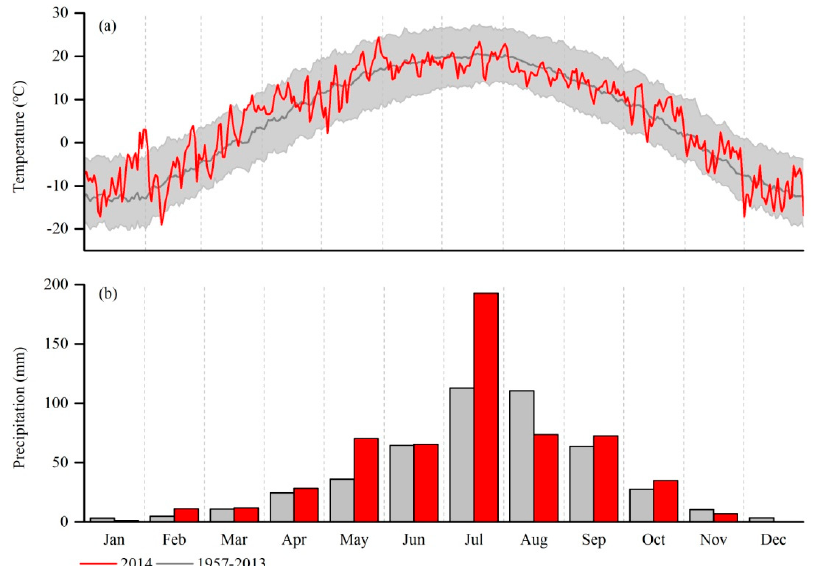
Figure 2. Comparison of ( a ) the mean daily air temperatures and ( b ) the monthly sums of precipitation for the monitoring year of 2014 (red) and the 1957–2013 average (light grey). The grey shading in ( a ) indicates the mean minimum and maximum temperatures averaged over the 1957–2013 period. Data were obtained from the nearest state standard meteorological station in Wuzhai (38°55 ′ N, 111°49 ′ E, 1401 m a.s.l., linear distance approximately 20 km north of the study site).